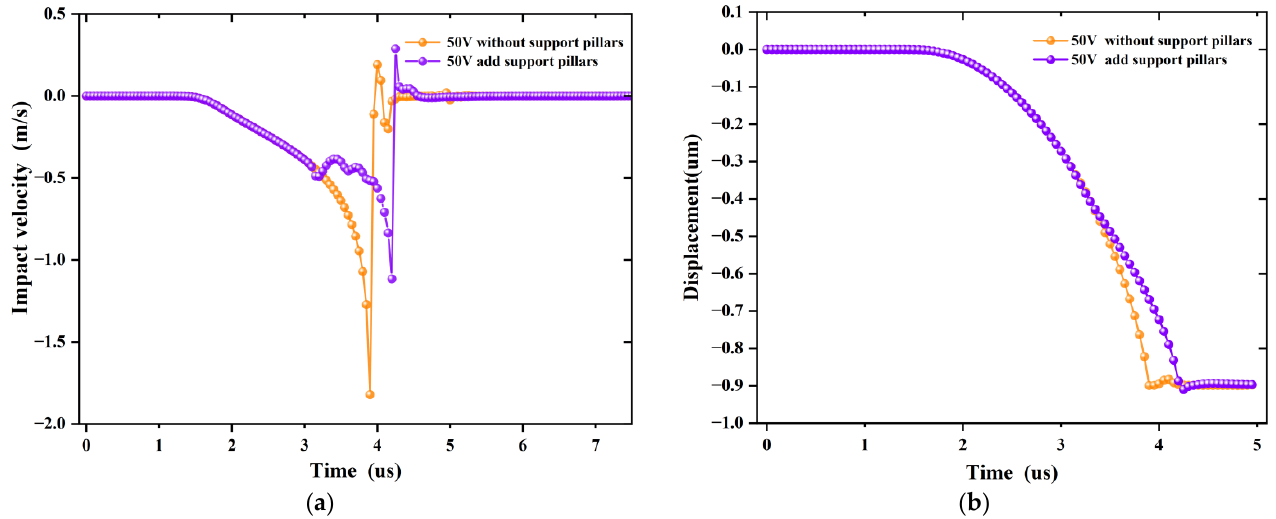
Figure 9. ( a ) Influence of adding support pillars on impact velocity, ( b ) Influence of adding support pillars on pull-in displacement.